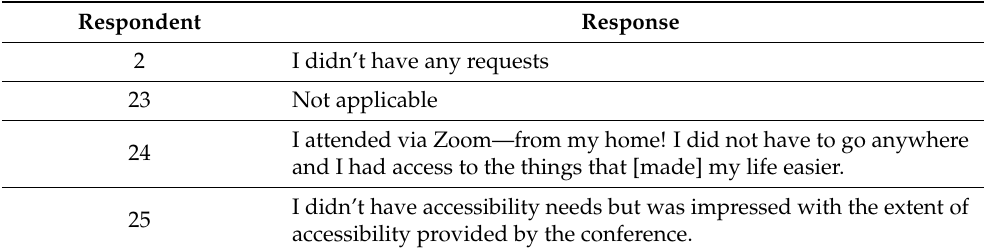
Table 6. Responses to the question “Were you satisfied with the way the conference team handled your accessibility needs? —No, please